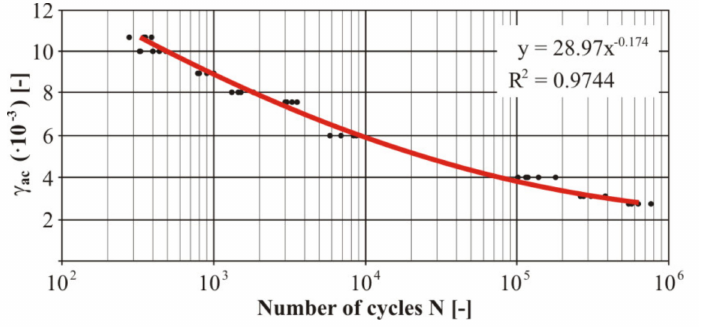
Figure 26. The final Manson − Co ffi n fatigue curve of the welded material EN AW 6063 under the torsion